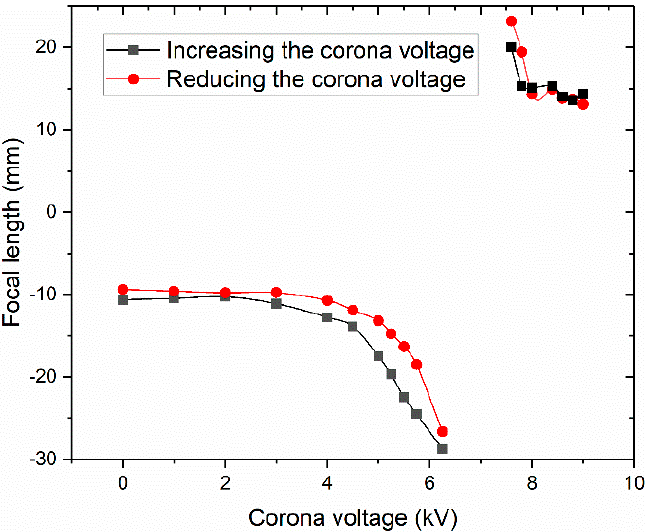
Figure 11. Focal length as a function of the voltage, which was gradually increased from 0 to 9.2 kV and then gradually decreased to 0 kV.